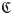
The estimated density function of the distribution of C, S and Φ on T8 under the α-γ-model with α = 0.7 and γ = 0.4.The percentiles of the tree in Fig 8 are also represented.